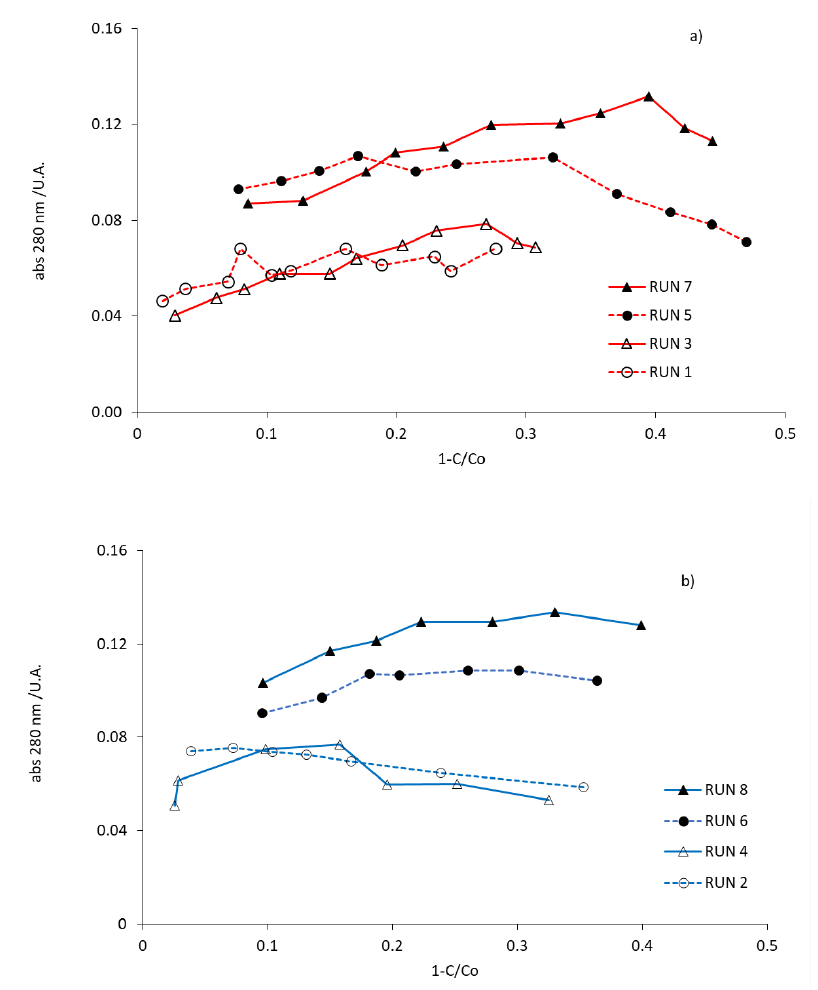
Figure 9. Values of absorbances detected at 280 nm as a function of the removal of DRN obtained for the eight runs: panel ( a ) reports the results at I = 0.5 mA; panel ( b ) reports the results at I = 1.25 mA.